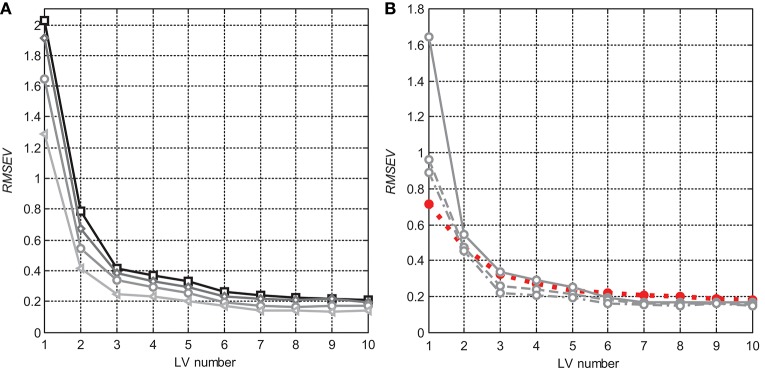
RMSE dependencies (LBO CV) on the number of LVs in PLS models: (A) for nonpreprocessed data in different moisture content ranges: D (squares), D20 (diamonds), D15 (circles), and D10 (triangles); and (B) D15 data with different smoothing degrees: none (solid), S15 (dashed), and S47 (dash-dotted), as well as for MSC preprocessing (red dotted, filled markers).